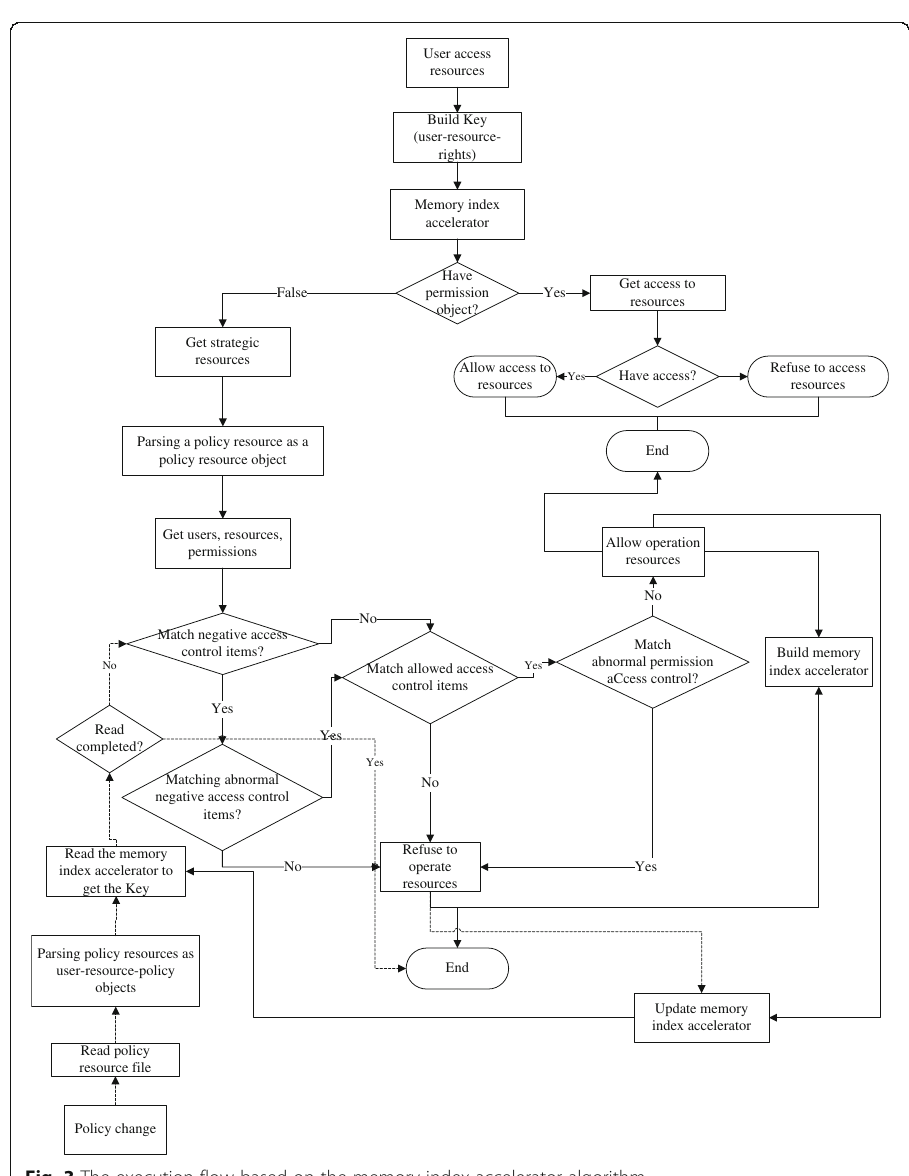
Fig. 3 The execution flow based on the memory index accelerator